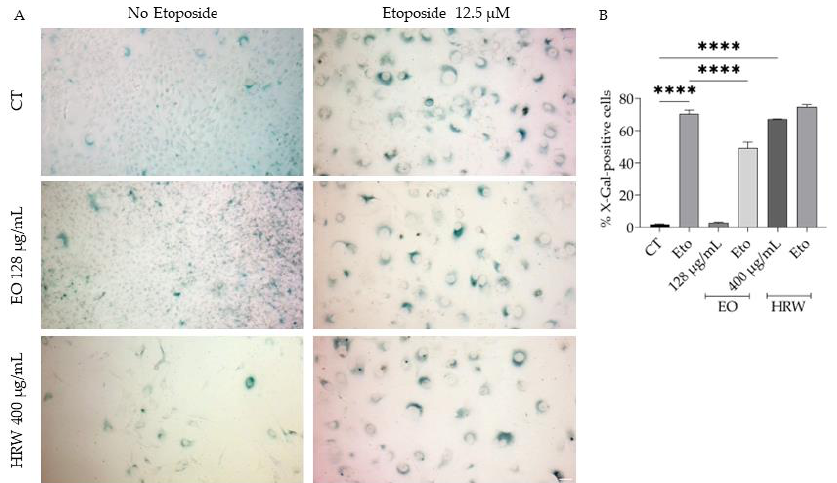
Figure 7. Effect of T. capitata EO and HRW on etoposide-induced cellular senescence. Representative bright-field images ( A ) and percentage of X-gal-positive cells after the mentioned treatments ( B ). **** p < 0.0001 when compared to control (CT) or etoposide (Eto) after one-way ANOVA followed by Dunnett’s multiple comparison test.